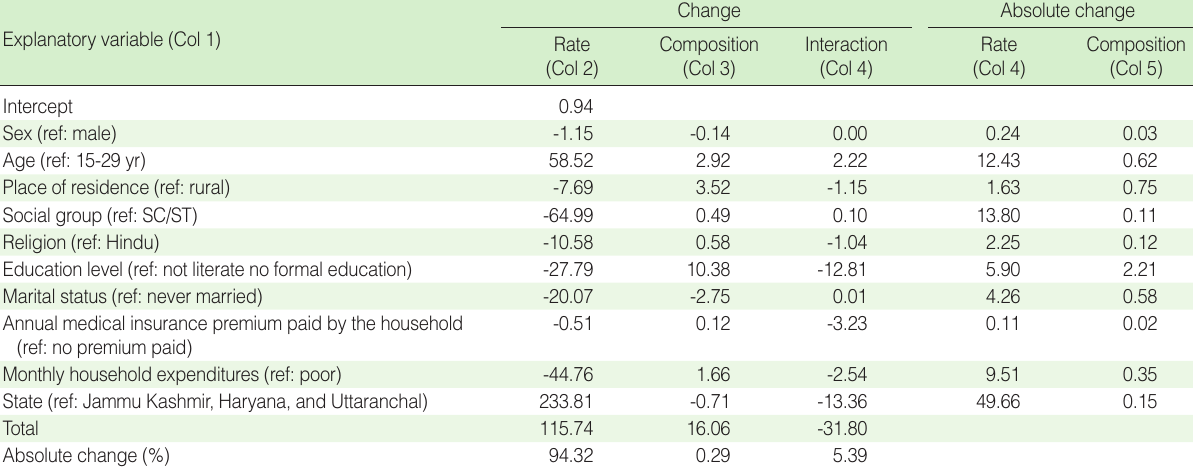
Table 5. Decomposition of changes in prevalence of cardiovascular diseases in India, 2004-2014 (by logit model) Explanatory variable (Col